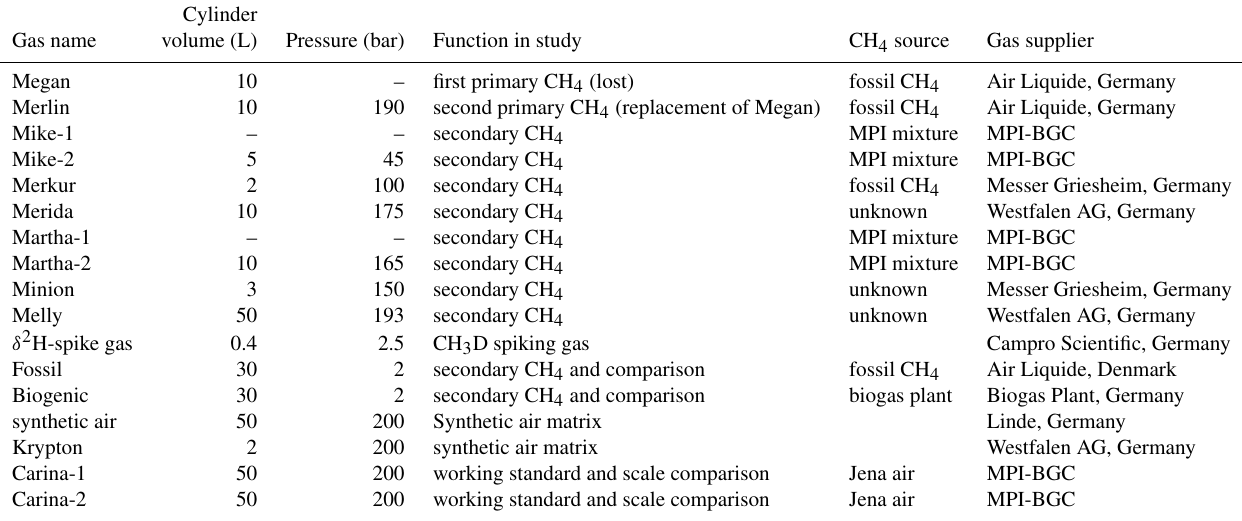
Table 1. Gases used for this study. Note that Mike-1 and Martha-1 were transitional CH 4 mixtures and do not exist anymore.